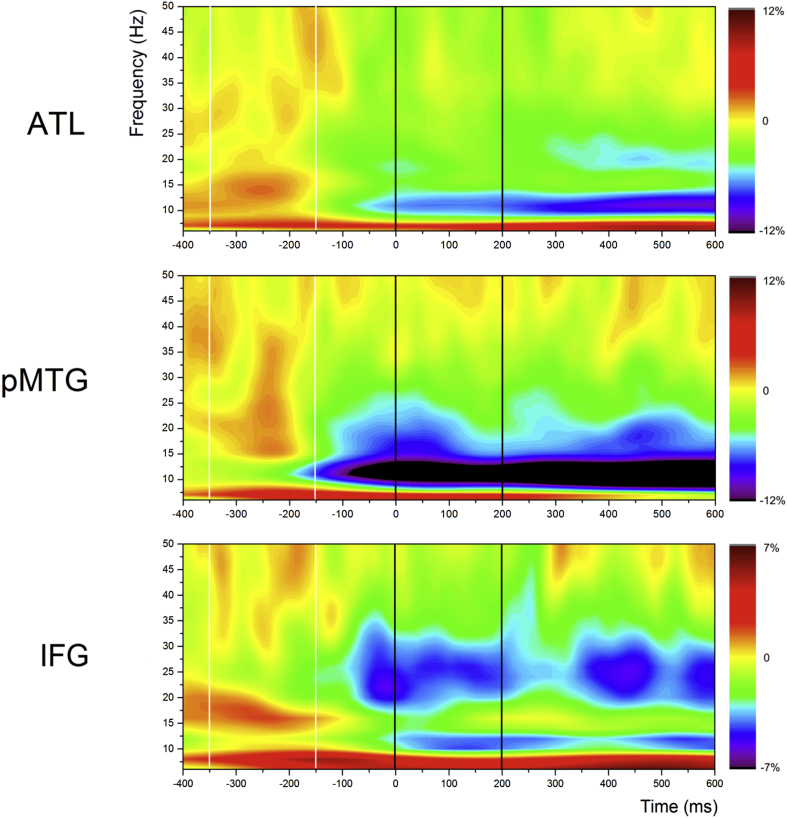
Total oscillatory power across the whole epoch for related trials, including both words presented in the relatedness judgement task. Presentation of the prime word (first word of the pair) is shown within white vertical lines, while presentation of the target word (second word of the pair) is illustrated within black vertical lines. Orange–brown indicates regions of power increase relative to the baseline, while green–purple indicates power decreases relative to the baseline, and yellow indicates no change from baseline.